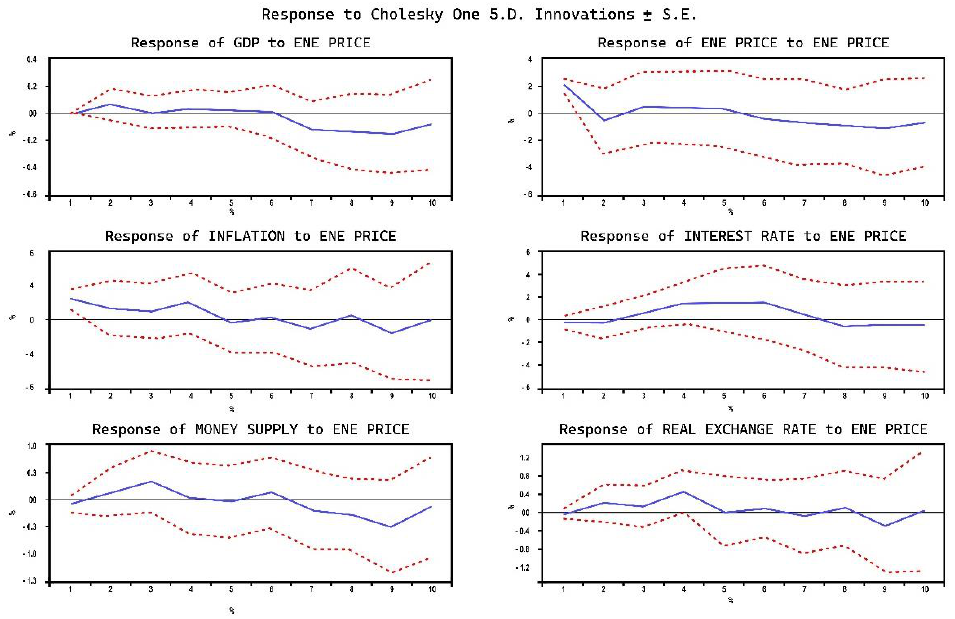
Figure 3. IRF to EPS (VAR IRF with intercept using annual data for 1980 – 2022).